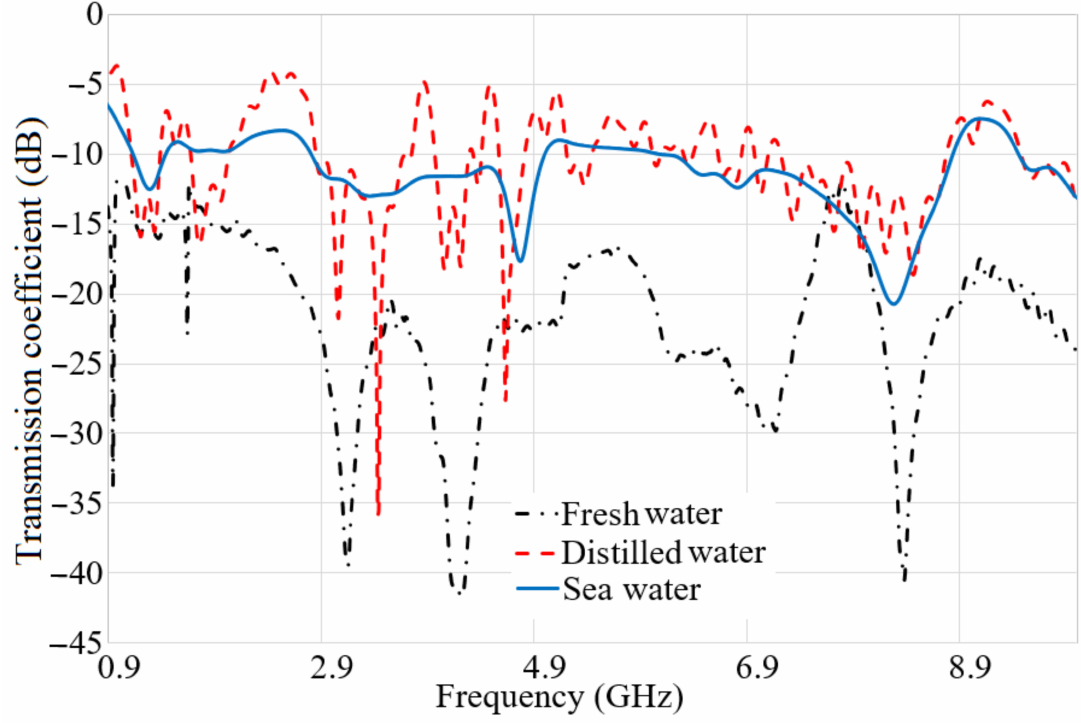
Figure 11. Measured S 21 result in fresh water, distilled water, and sea